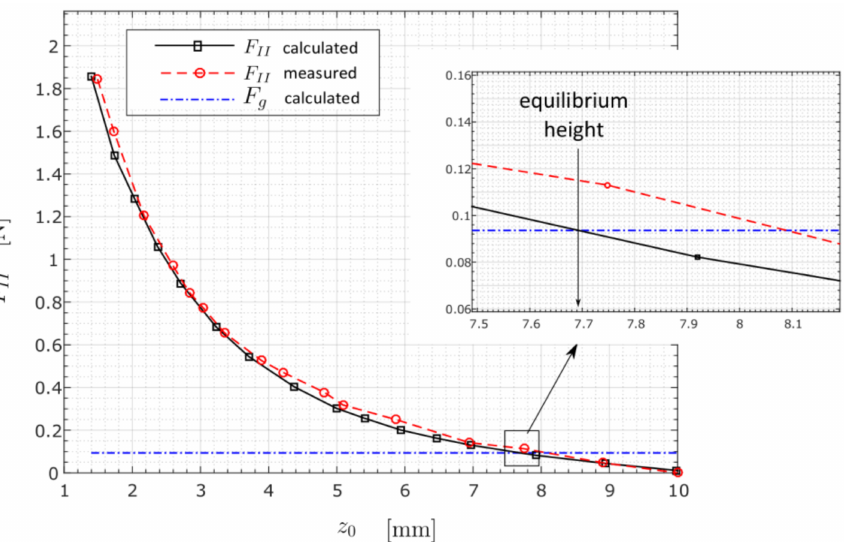
Figure 14. The measured and calculated curves of magnetic levitation force F II for the case r = 3 mm. The force was calculated by the SIM. An intersection between the gravitational F g and mag-netic levitation force F II is shown in the magnified window. Measured data were acquired from ref.